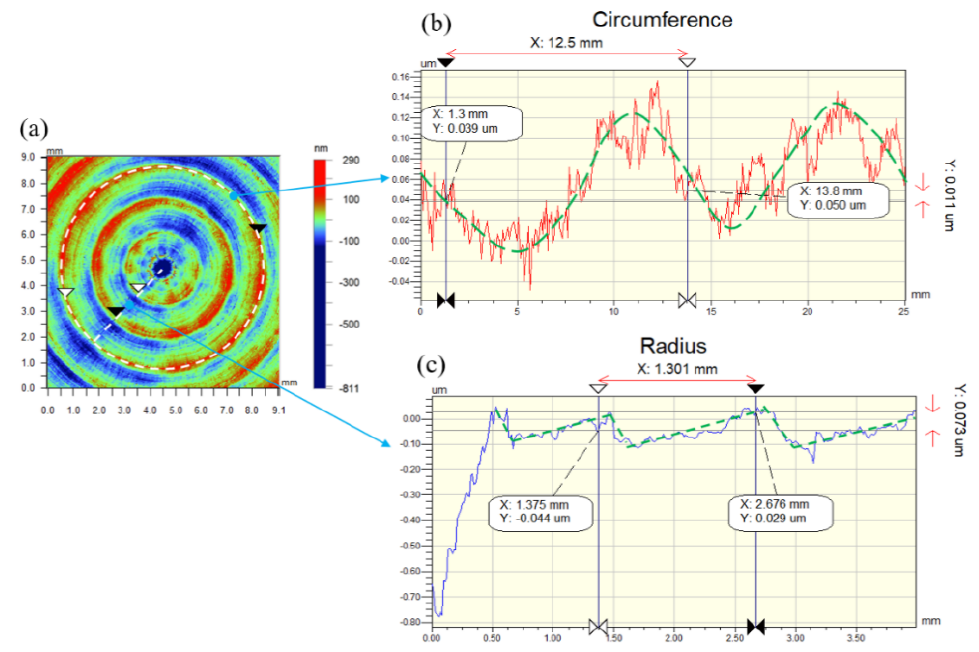
Figure 12. Analysis results of the workpiece surface topography. ( a ) The result of the workpiece surface. ( b ) The quality result when a circle R = 4 mm. ( c ) The quality change of the selected line segment.